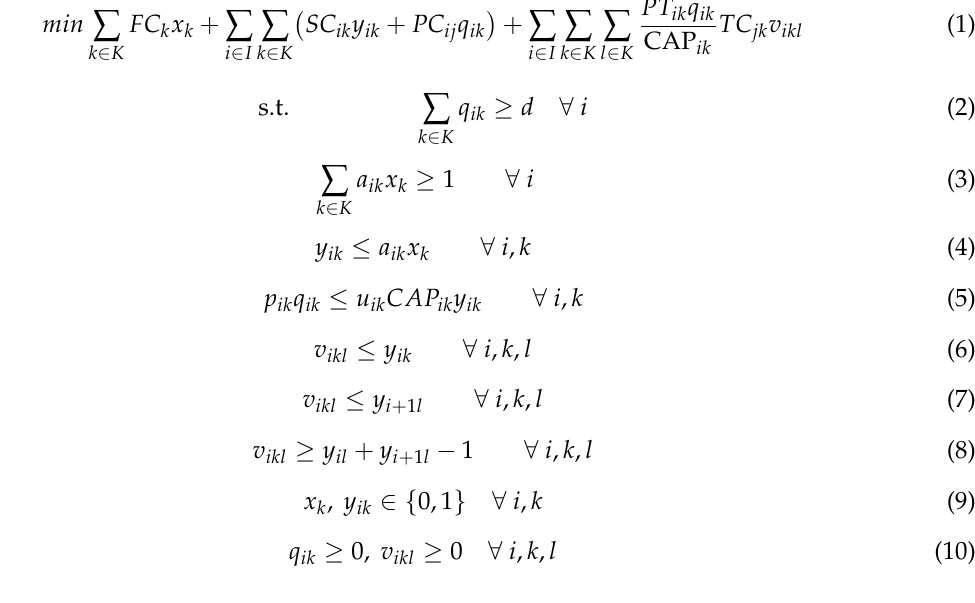
Table 1. Notations for dynamic supply chain